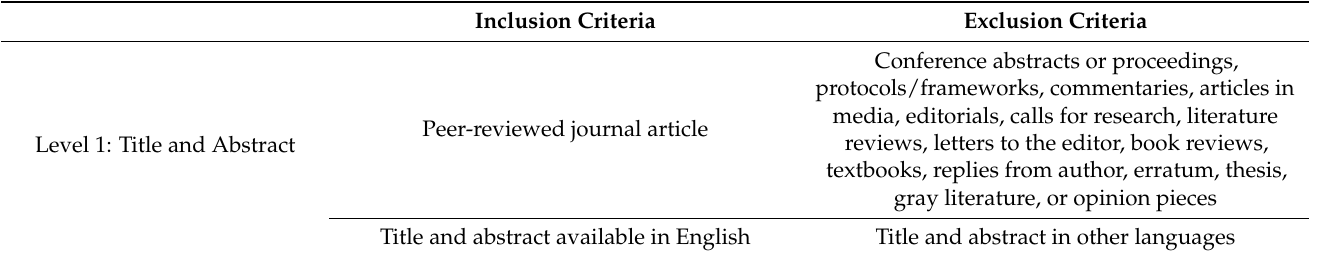
Table A1. Inclusion/Exclusion Criteria for level 1 and 2 Screening. Inclusion Criteria Exclusion